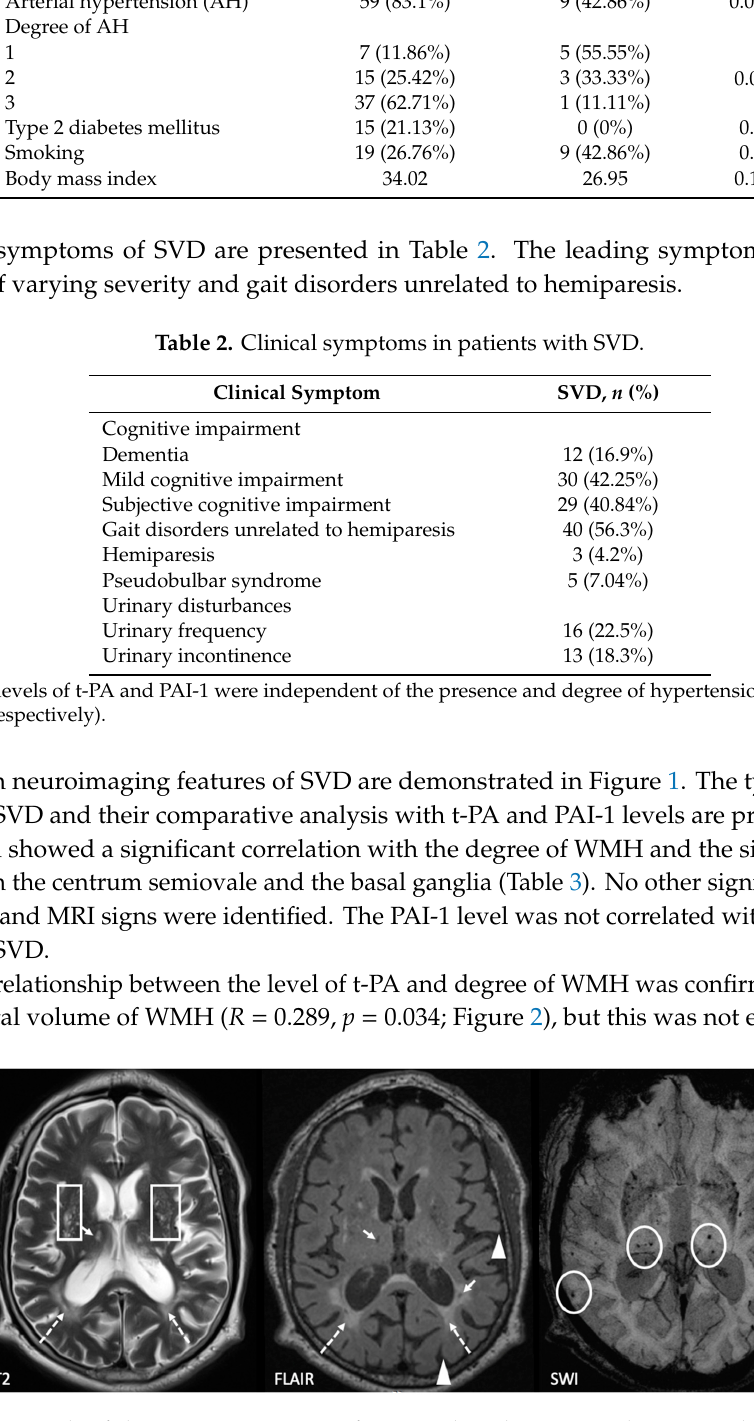
Table 1. Main demographic parameters and risk factors in patients with cerebral small vessel disease (SVD) and in the control group.